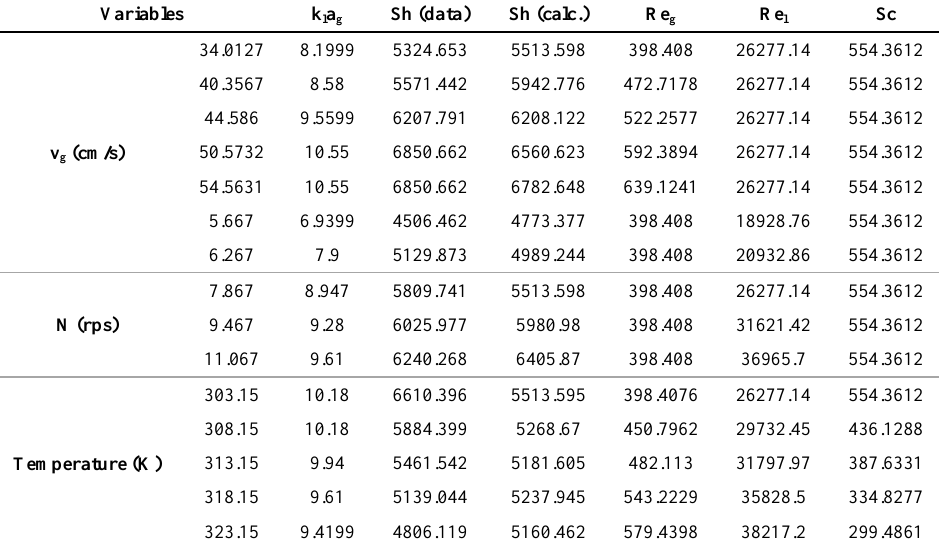
Table 3. Relationship between Sherwood's number (both experimental data and calculation), Re, Rel, and Schmidt’s number on various clag values